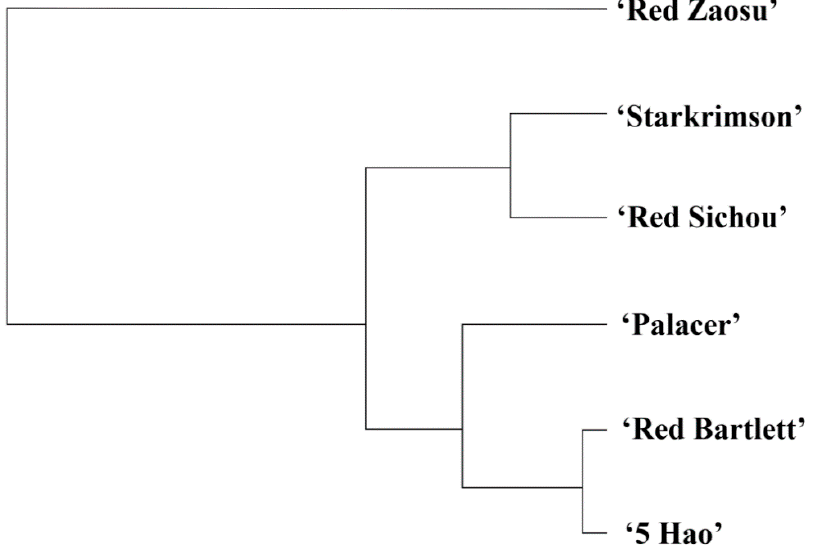
Figure 6. Dendrogram of the six red pear cultivars derived from the hierarchical cluster analysis.